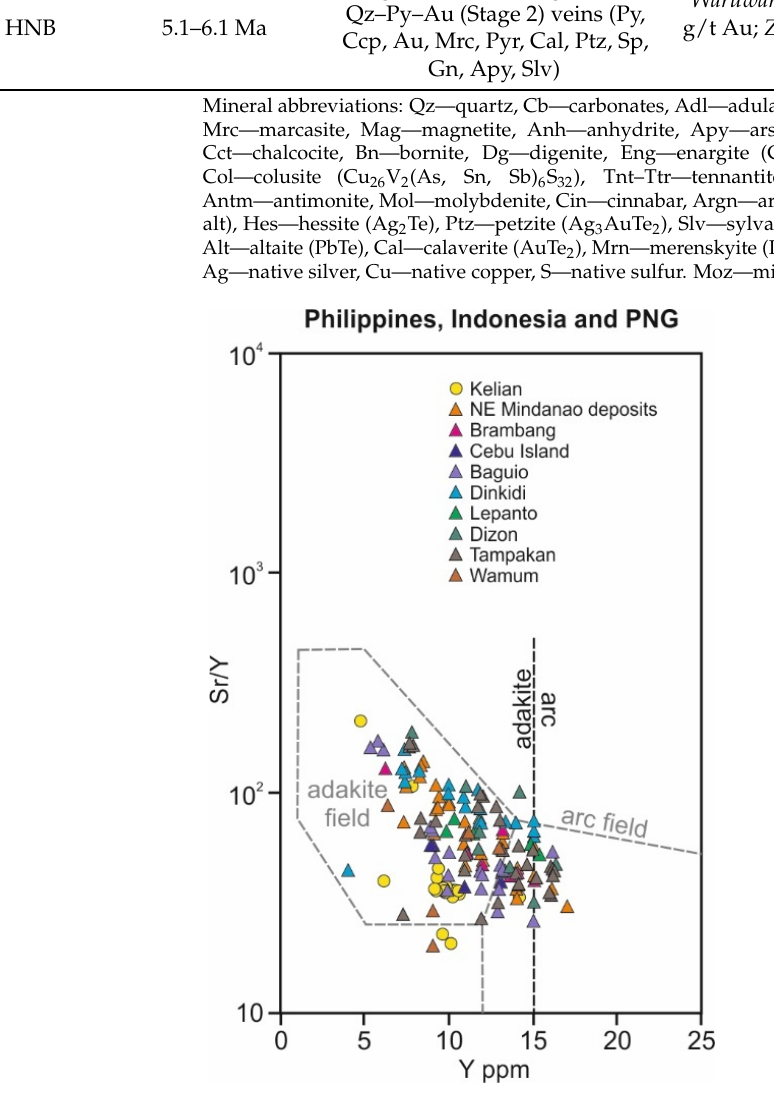
Figure 13. Variations of Sr/Y versus Y (ppm) in igneous rocks associated with porphyry Cu–Au–Mo (triangles) and epithermal Au–Ag (circles) deposits in the Philippines, Indonesia and Papua New Guinea (PNG). Data sources: Kelian [207]; NE Mindanao [103,192]; Brambang [209]; Cebu Island (Atlas, Lutopan) [195]; Baguio mineral district [103,193,194,197]; Dinkidi [190]; Lepanto cluster [103,194,197]; Dizon [198]; Tampakan [191,196]; Wamum [212]. The giant Atlas porphyry system (1420 Mt at 0.45% Cu, 0.018% Mo, 0.24 g/t